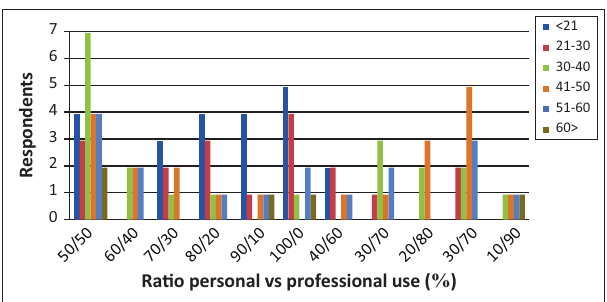
FIGURE 4: Web usage in terms of personal verses professional